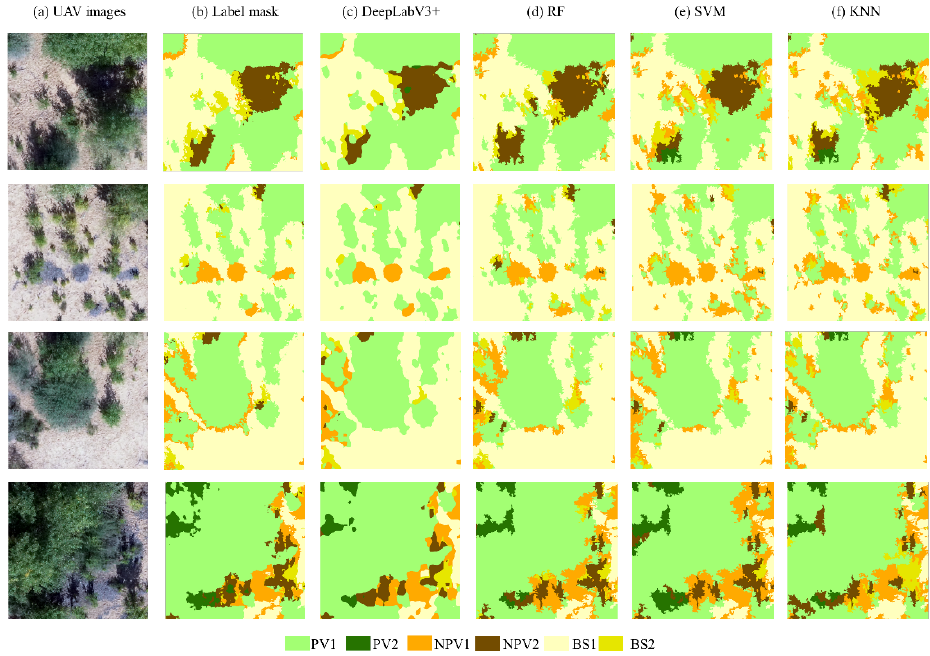
Figure 8. Comparison of detailed estimation results between deep learning and machine learning methods. ( a ) Original images; ( b ) Label masks; ( c ) Estimation results by DeepLabV3+; ( d ) Estimation results by RF; ( e ) Estimation results by SVM; ( f ) Estimation results by KNN.